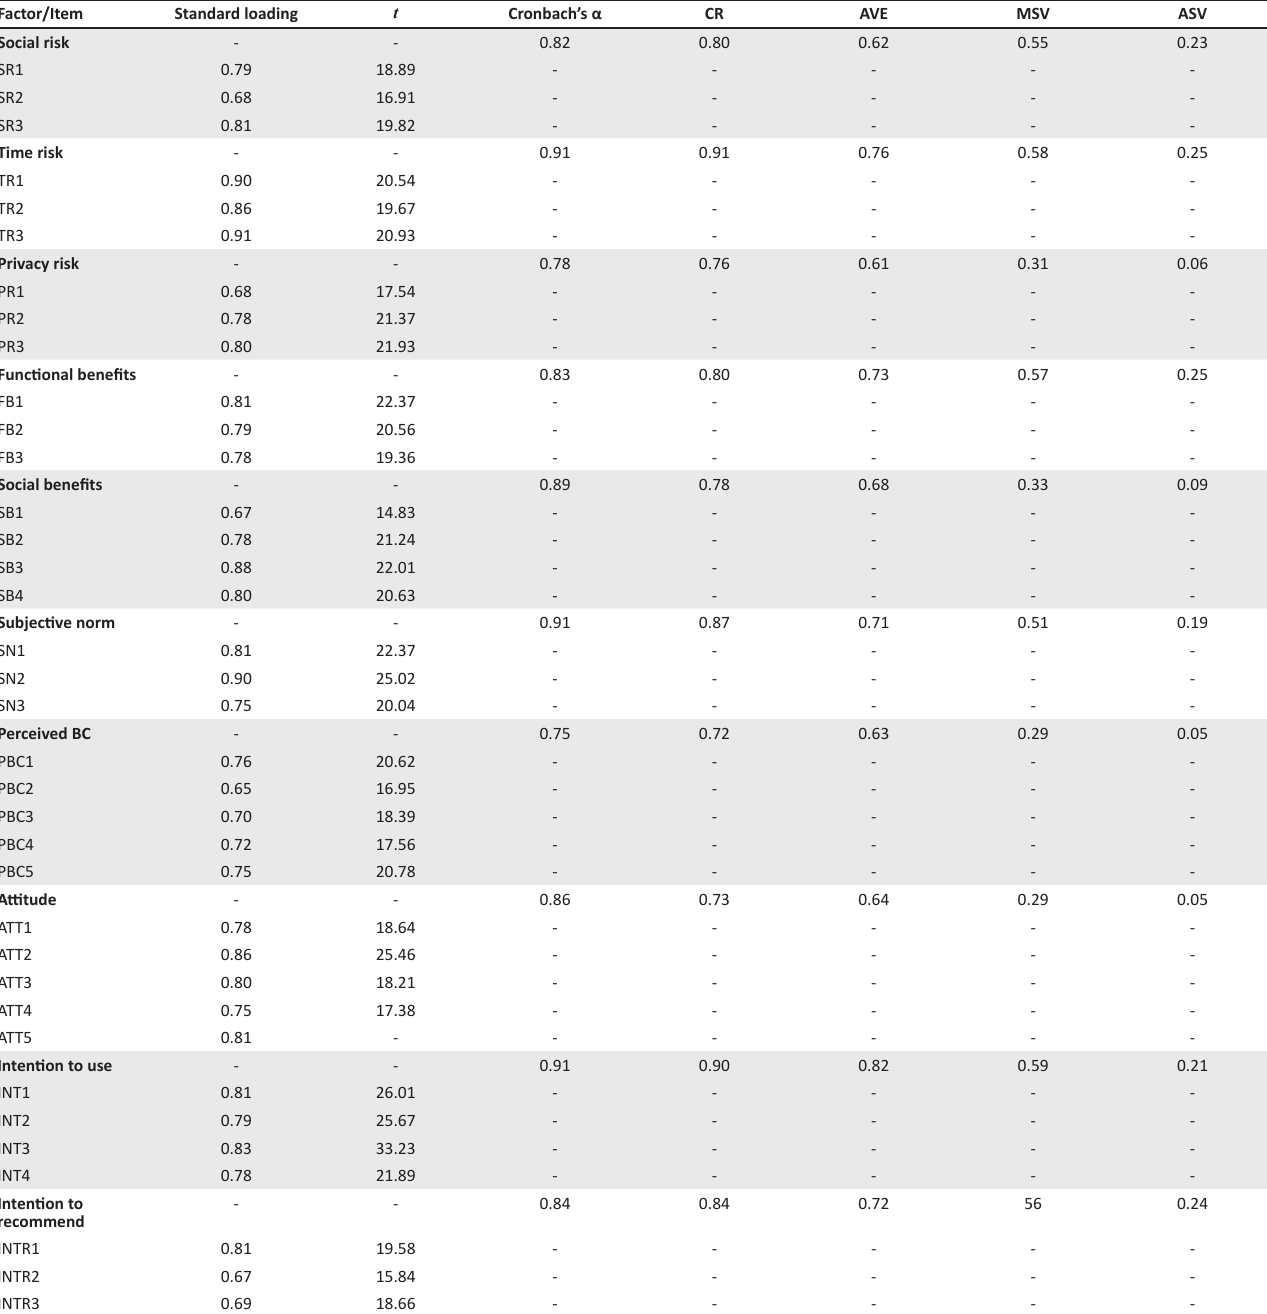
TABLE 2: Confirmatory factor analysis